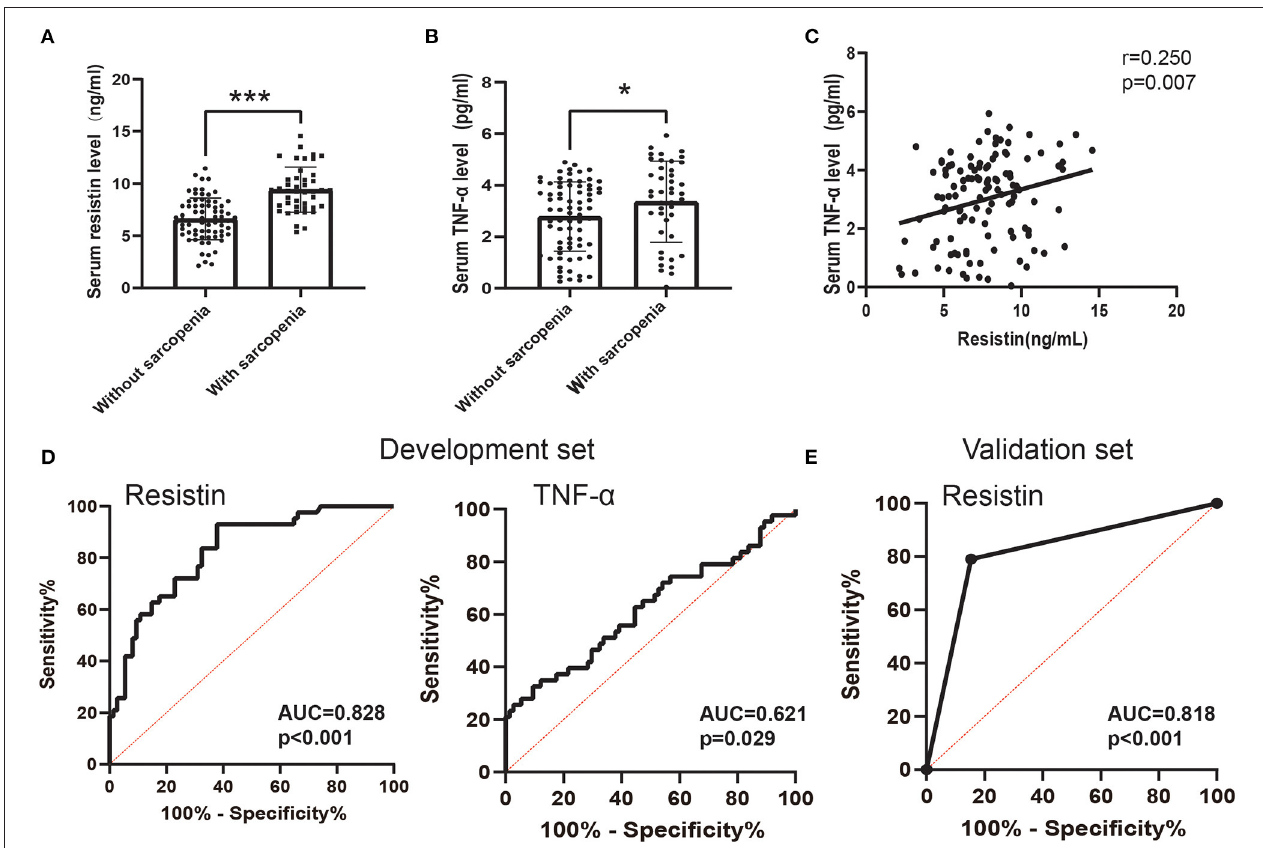
FIGURE 3 | The predictive value of the serum resistin level. (A) Serum resistin levels differed between patients with sarcopenia and patients without sarcopenia; (B) Serum TNF- α levels differed between patients with sarcopenia and patients without sarcopenia; (C) Relationship between serum resistin levels and serum TNF- α levels; (D) Receiver operating characteristic curve analysis of serum resistin levels and serum TNF- α levels for the prediction of sarcopenia in the development set; (E) Receiver operating characteristic curve analysis of serum resistin levels for the prediction of sarcopenia in the development set. * p < 0.05, *** p <